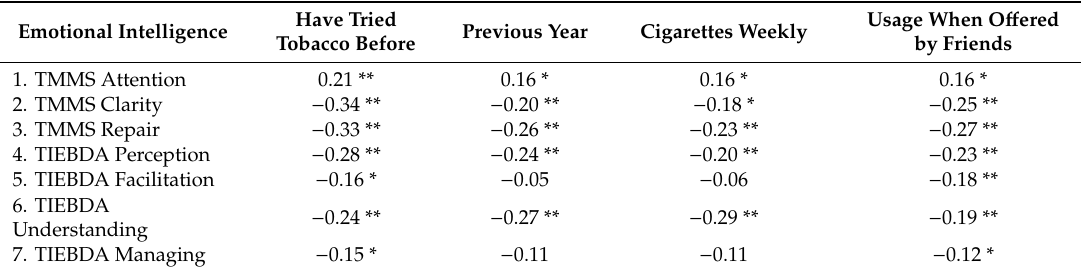
Table 2. Biserial-Point Correlation between Trait and Ability EI Variables and Tobacco Use. Emotional